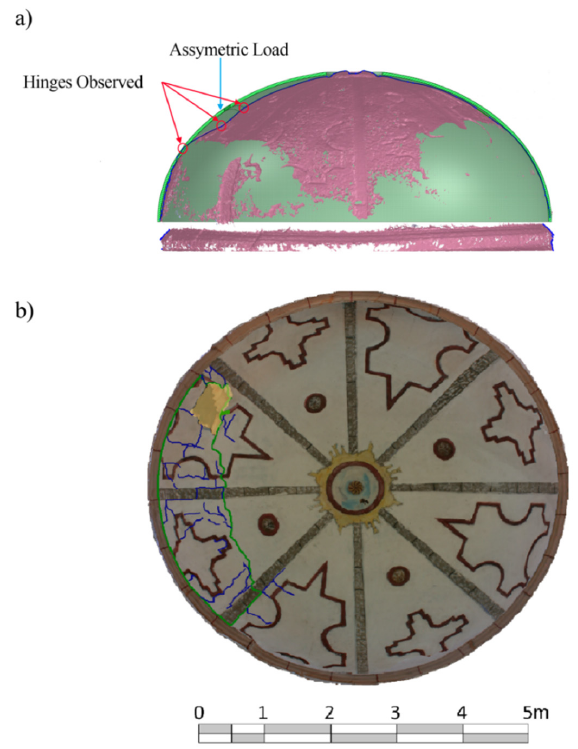
Figure 7. Results of the visual inspection over the different photogrammetric products: ( a ) Surface comparison between the initial proposed model and the most deformed one estimated by the SfM point cloud; ( b ) Damage inspection in the orthophoto, in green the main observed cracks, in blue the secondary cracks, in yellow the material removal.